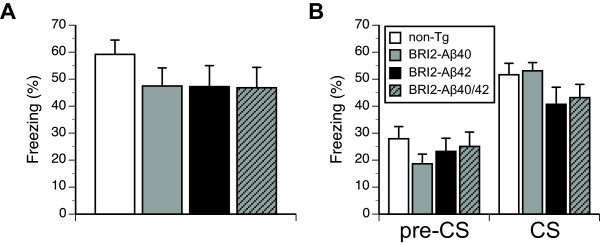
Conditioned fear memory of BRI2-Aβ mice at the onset (12 months of age) of Aβ1-42 deposition in BRI2-Aβ1-42 mice. (A) Context fear memory and (B) tone fear memory tested after 48h and 72h following CS-US pairing. Freezing to tone (CS) was stronger than freezing to altered testing chamber (pre-CS) phase (p < 0.01, phase effect). Error bars represent s.e.m.